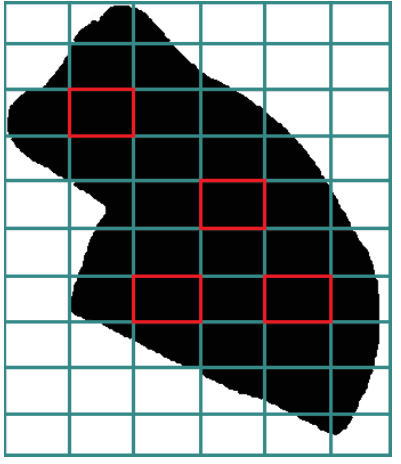
Figure 10. Area of Interest in